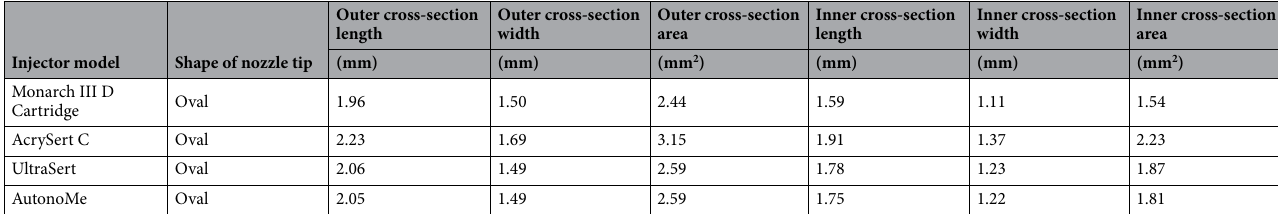
Table 1. Parameters of nozzle tips for all the injector systems.